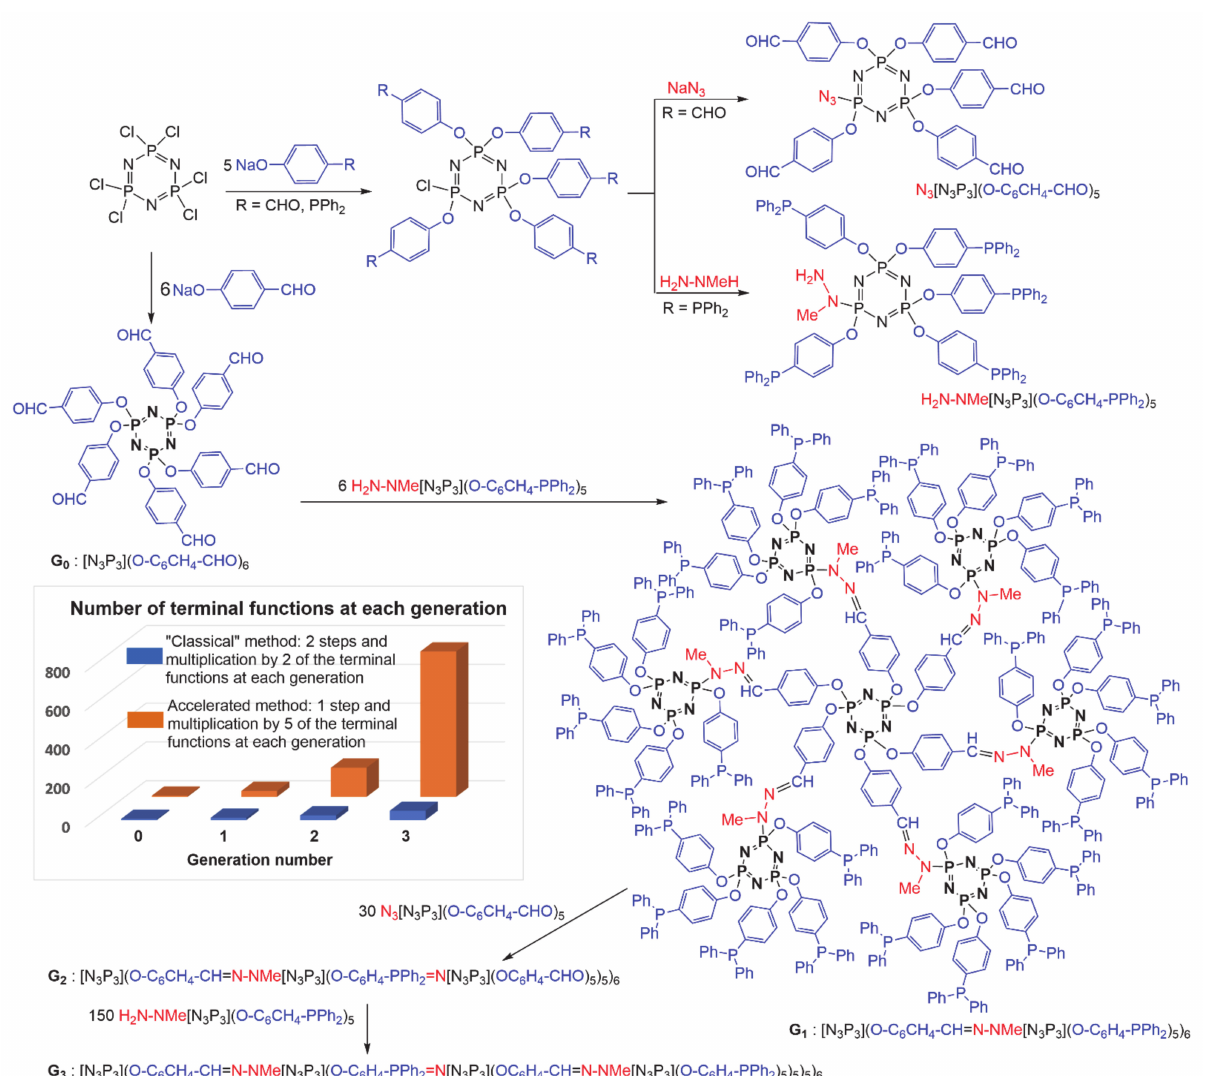
Scheme 4. Two examples of AB 5 derivatives of cyclotriphosphazene, used for the synthesis of layered phosphorus dendrimers. Full structure of generations 0 and 1, and linear structure of the four generations of the dendrimers, from G 0 to G 3 , having one, two, three or four layers of cyclotriphosphazenes. The graph represents the number of terminal functions at each generation, depending on the method of synthesis: widely used methods needing two steps for each generation and a multiplication by 2 at each generation (dark blue), or the accelerated method shown in this Scheme, one step for each generation, and a multiplication by 5 at each generation